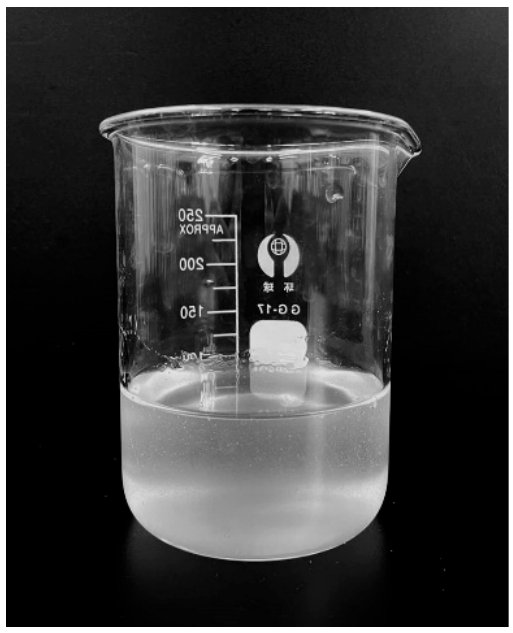
Figure 3. The base fluid of JK101 guar gum (0.45 wt.%).